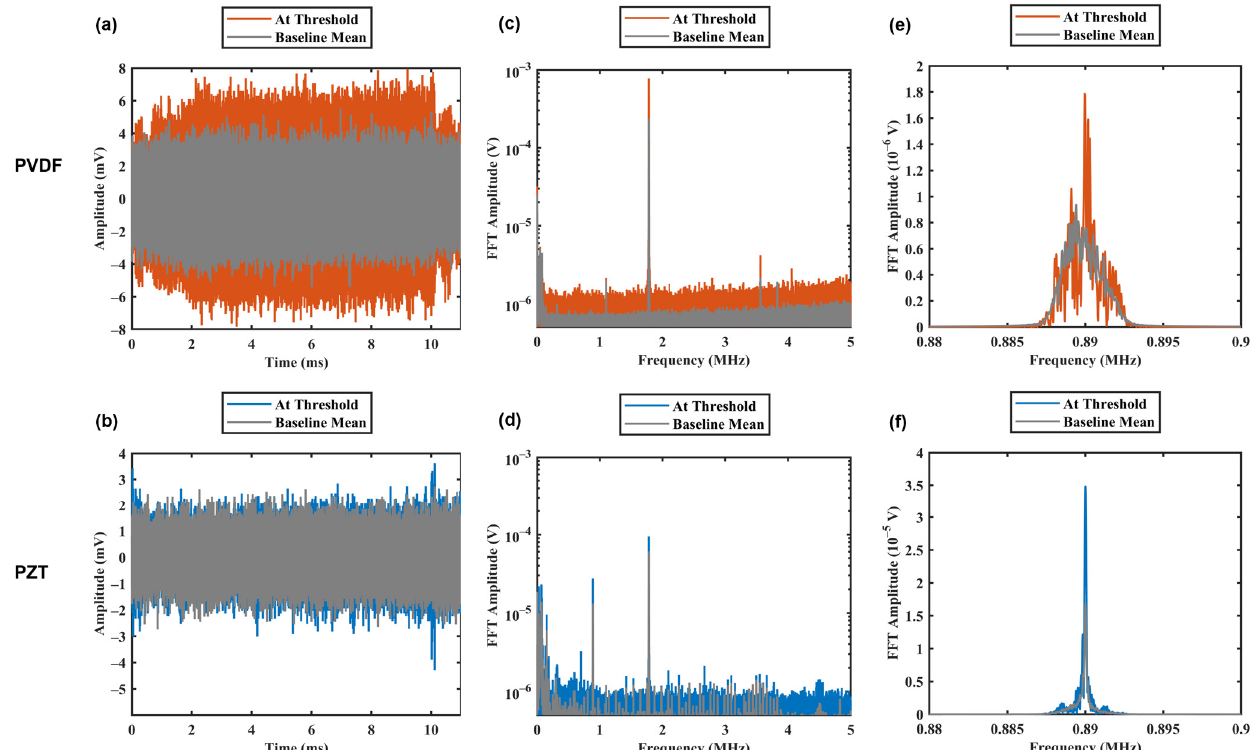
Figure 8. Cavitation signals acquired by PVDF ( a , c , e ) and PZT ( b , d , f ) in ( a , b ) time domain and ( c , d ) fast Fourier transform (FFT) amplitude at threshold pressures. Figures ( e , f ) show the change at the subharmonic, with seven times zero padding added to all data sets. Baseline mean is the arithmetic mean of 10 baseline acquisitions. Raw data were filtered with a fourth order Butterworth filter at the subharmonic frequency with 4000 Hz bandwidth.